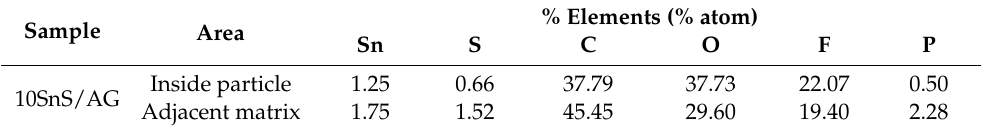
Table 2. EDS analysis after cycling of the area inside the particles and outside the adjacent matrix.